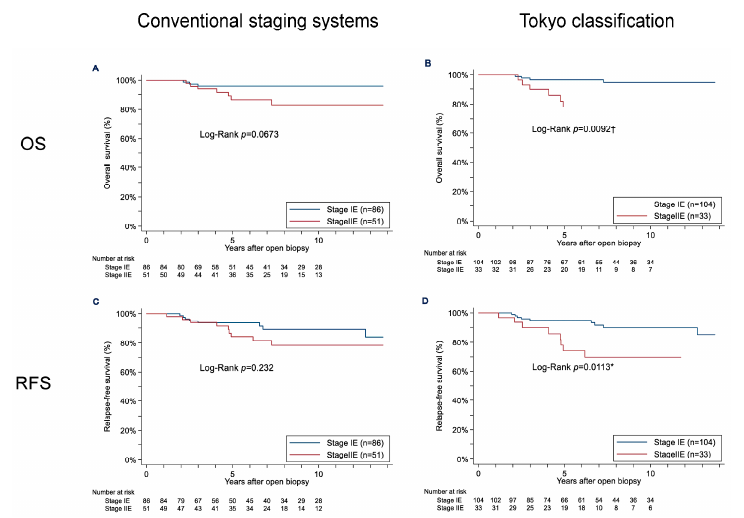
Figure 2. The overall survival (OS) and relapse-free survival (RFS) curves for the patients with stage IE and stage IIE primary thyroid mucosa-associated lymphoid tissue (MALT) lymphoma classified with the conventional staging systems ( A , B ) and the modified staging system (the Tokyo classification) ( C , D ). * p < 0.05. † p < 0.001.